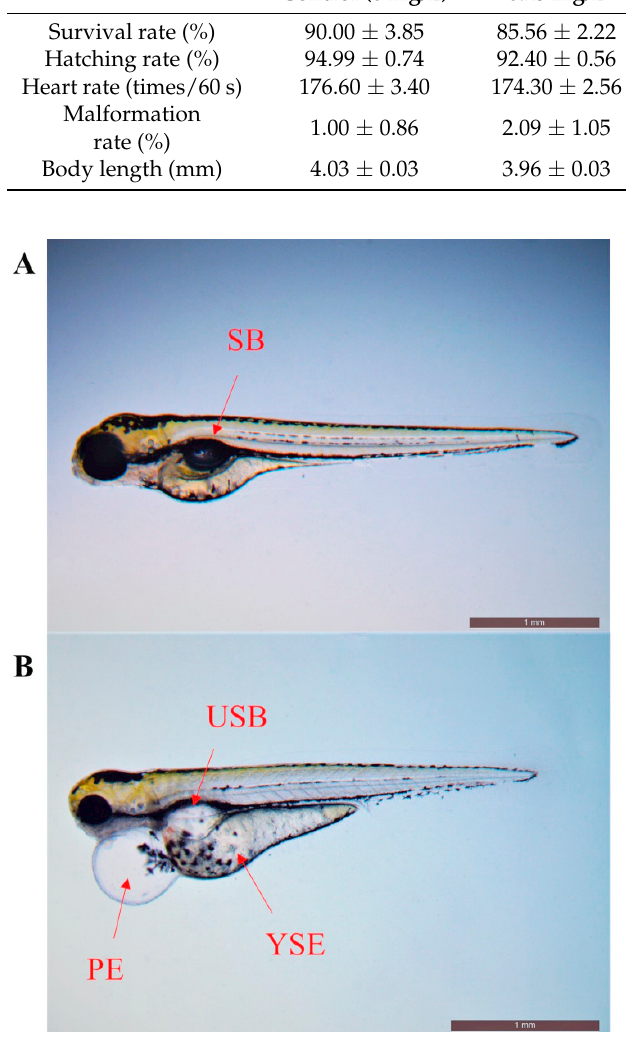
Figure 1. Images of zebrafish larvae at 120 hpf in control ( A ) and 1 mg/L difenoconazole exposure ( B ) groups. SB: swim bladder; USB: uninflated swim bladder; PE: pericardial edema; YSE: yolk sac